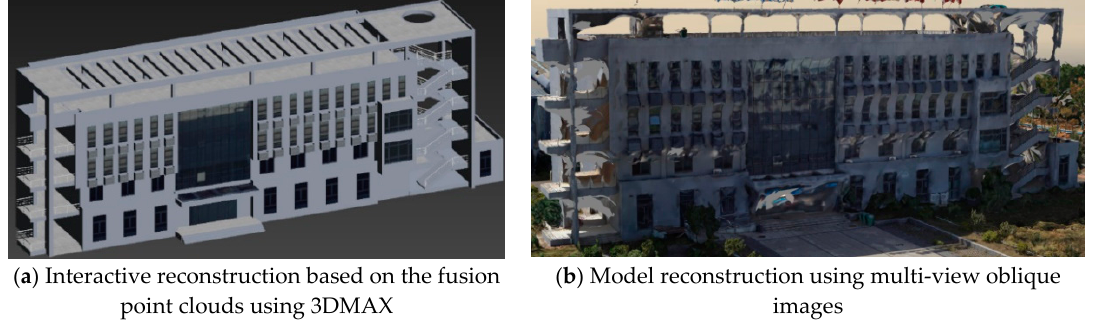
Figure 14. Reconstruction results of two comparison methods. Table 1. Statistics of relevant measures from different reconstruction methods.